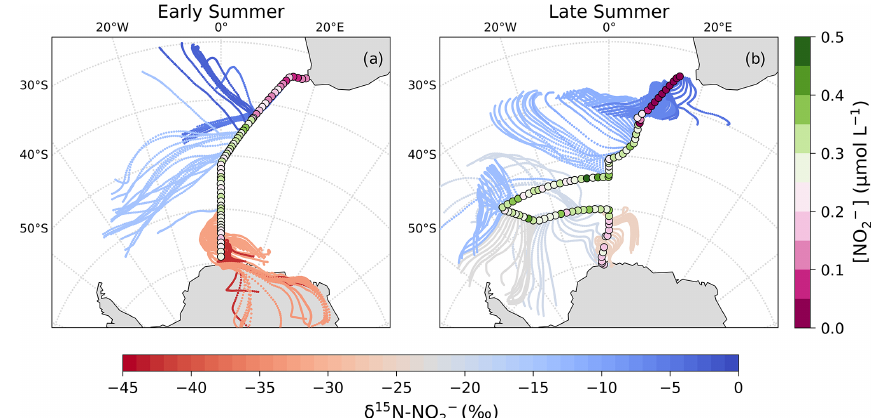
Figure 4. The 72h AMBTs computed for each hour of the voyage during early (a) and late (b) summer, when the HV-AS was operational for more than 45min of the hour. AMBTs are colour-coded by the weighted average δ 15 N of atmospheric nitrate ( δ 15 N–NO − by the horizontal colour bar. Overlaid are the surface ocean nitrite concentrations (circles; [NO − and represented by the vertical colour bar.